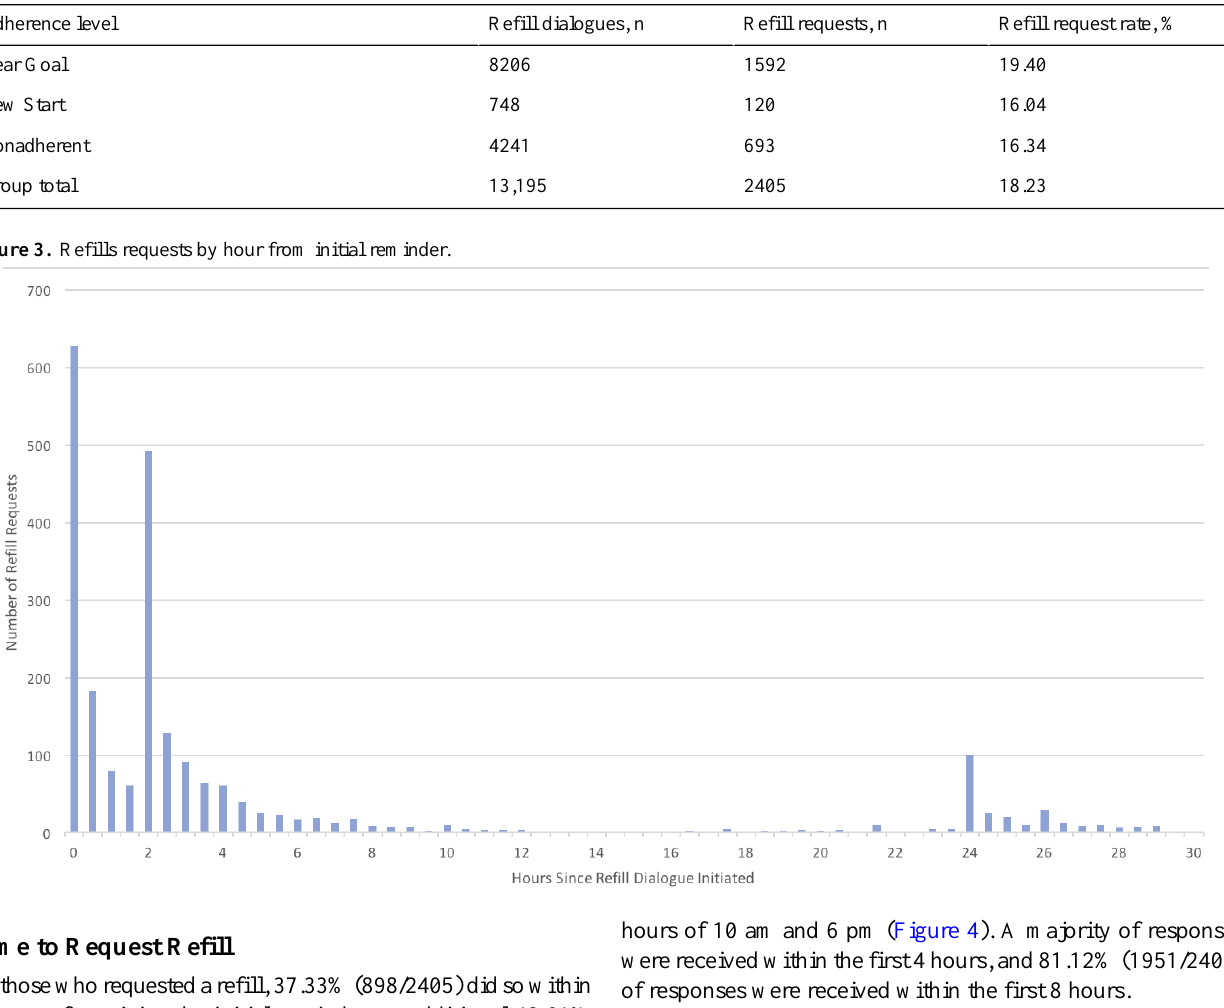
Table 3. Refill request rate for text message group by adherence level.